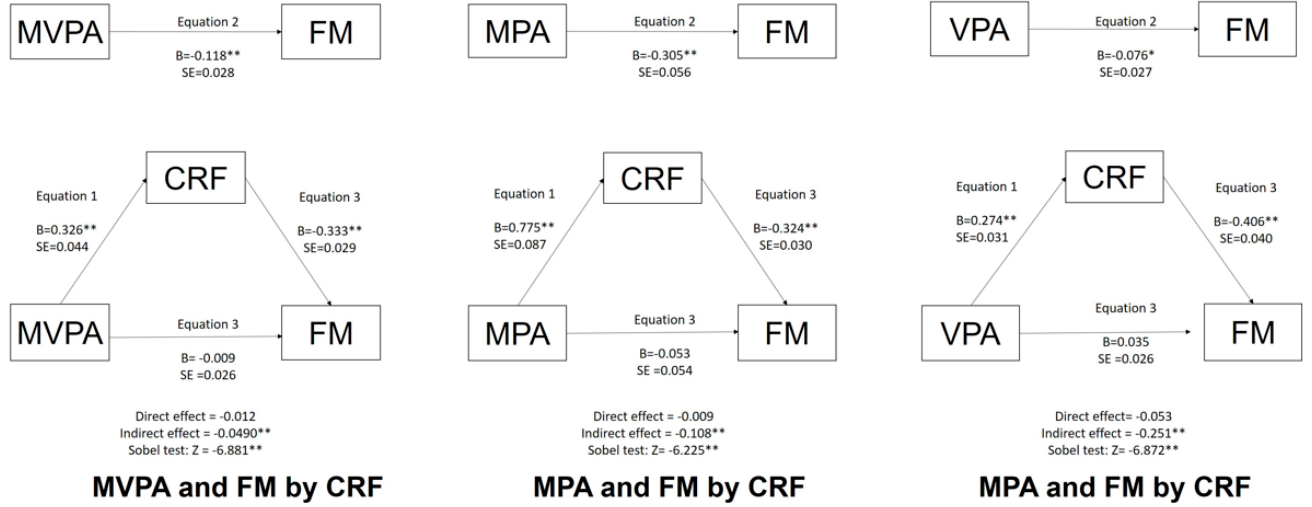
Figure 1. Mediation of MVPA/MPA/VPA and FM by CRF for children. Legend: ** p < 0.001; * p < 0.05; MVPA = moderate to vigorous physical activity; MPA = moderate physical activity; VPA = vigorous physical activity; CRF = cardiorespiratory fitness; FM = fat mass.